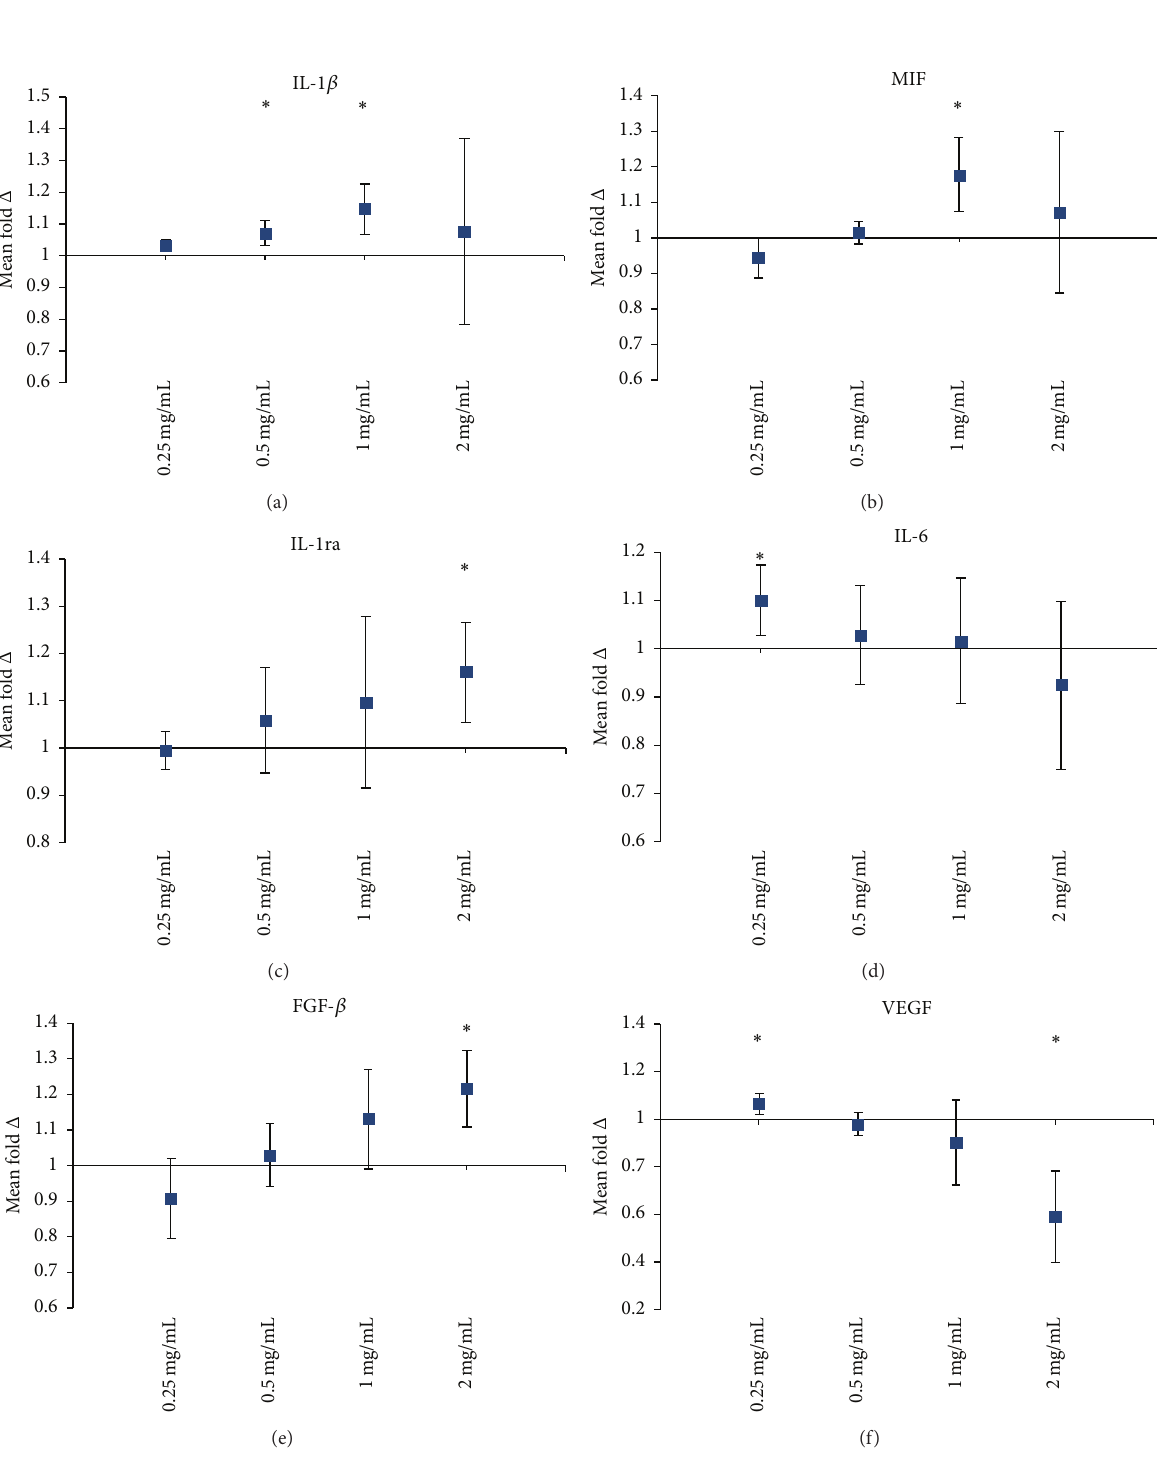
Figure 7: Fold change of cytokine secretion by MSCs with HA treatment. Conditions were all cultured in either control media or HA media for three days after the media change. Conditions ( 𝑥 -axis) were grown in flasks (B–E) HA media, ranging from 0.25 to 2 mg/mL of HA. These were all compared back to the control condition (cells grown control media, flask (A)). Average fold change in fluorescence ( 𝑛 = 3 ) ± upper and lower confidence intervals at 95% ( 𝑦 -axis). Cytokines with a fold change less than one indicate a decrease with HA media treatment; a fold change greater than one indicates an increase in the cytokine with HA treatment ( ∗ cytokines with a fold change clear of the axis at 1 reported as significant). Interleukin-1 𝛽 (IL-1 𝛽 ), macrophage migration inhibitory factor (MIF), Interleukin-1 receptor antagonist (IL-1ra), Interleukin- 6 (IL-6), fibroblast growth factor-basic (FGF- 𝛽 ), and vascular endothelial growth factor (VEGF). See Supplemental Data for complete list of significantly changed cytokines and numerically tabulated